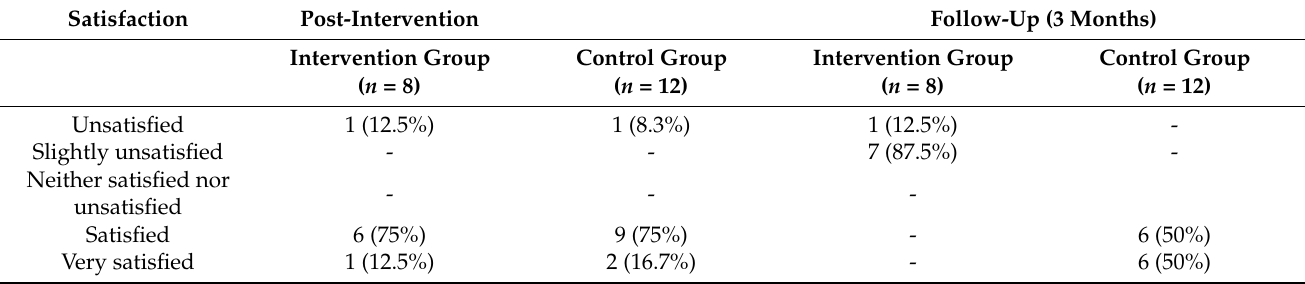
Table 4. Description of satisfaction after the intervention and at the 3-month follow-up in both